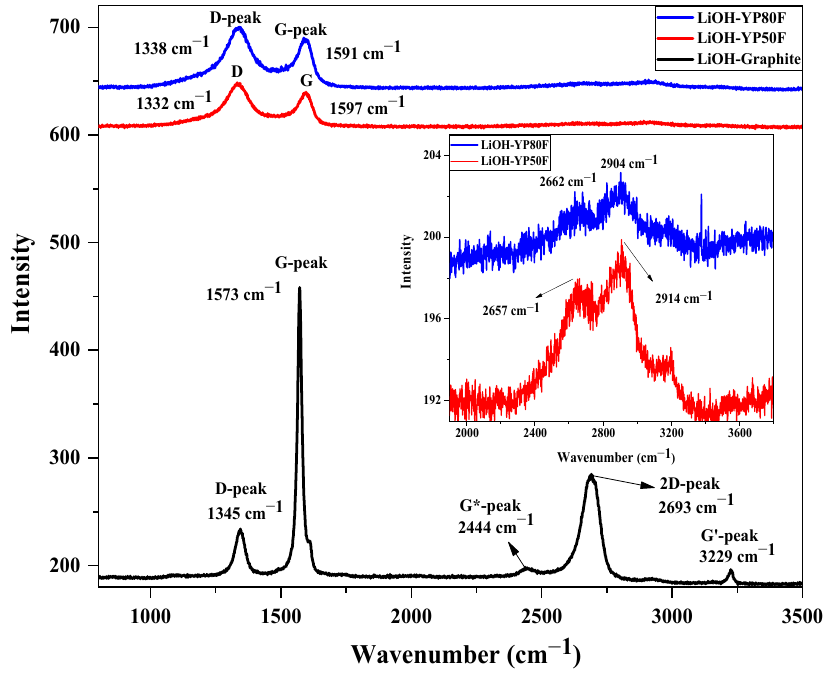
Figure 8. Raman spectra of the LiOH-Graphite, LiOH-YP50F and LiOH-YP80F sample (G*-two-phonon processes).